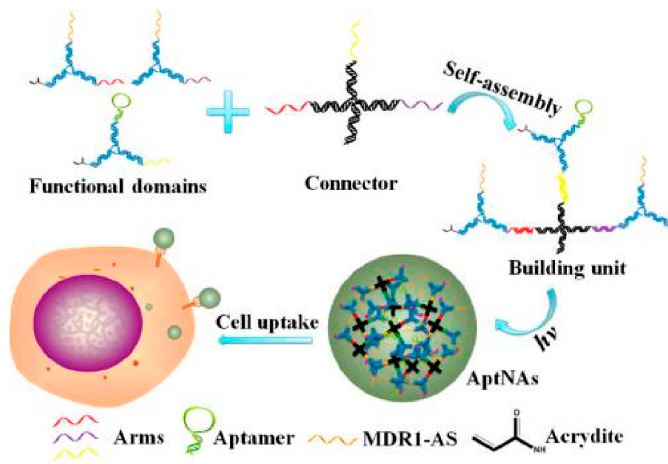
Figure 9. Schematic illustration of multifunctional self-assembled building units and photocrosslinked nanoassembly structure for targeted cancer phototherapy. Multifunctional DNA sequences, including aptamers, acrydite-modified single-stranded DNA, and antisense oligonucleotides are self-assembled to form Y-shaped functional domains, which further link via X-shaped connectors to form building units